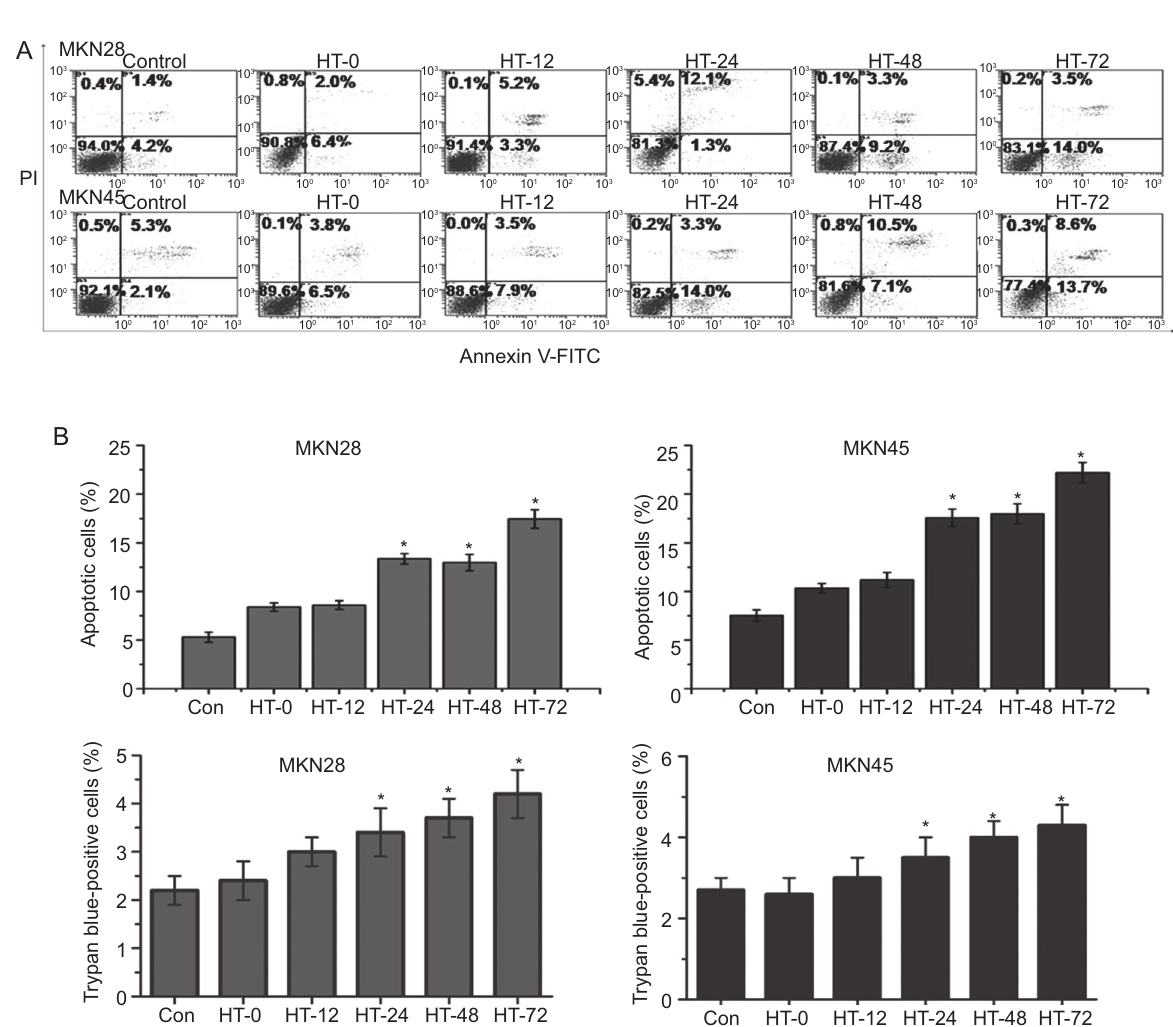
Figure 2. Hyperthermia (HT) induced apoptosis in gastric cancer cells. MKN28 and MKN45 cells were treated with HT (42 6 C for 1 h) and gastric cancer cells cultured at 37 6 C were used as control (Con). A , Apoptosis rate in MKN28 and MKN45 cells at 0, 12, 24, 48, and 72 h after 1 h of HT. The apoptotic cells were stained with Annexin V/PI and analyzed by flow cytometry. The data are shown in histograms. B, Cell necrosis rates of MKN28 and MKN45 cells were determined using the trypan blue exclusion test for up to 72 h after 1 h of HT. Results are reported as means ± SD for 3 independent experiments. *P , 0.05 compared to control (Dunnett test). PI = propidium iodide; FITC = fluorescein isothiocyanate.